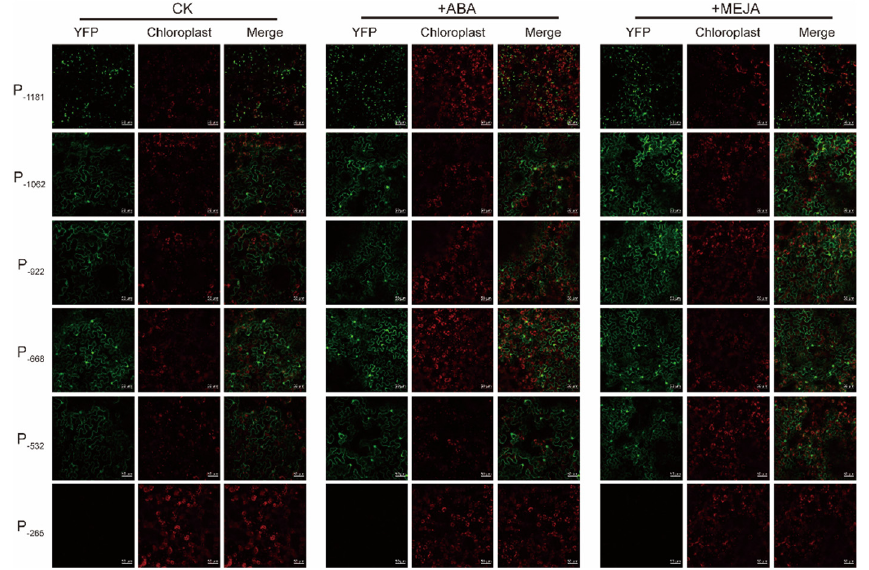
Figure 5. Responses of truncated PtAOS1 promoters to ABA (abscisic acid) and JA (CK, control samples treated with distilled water). Scale bar in white represents 50 µm.